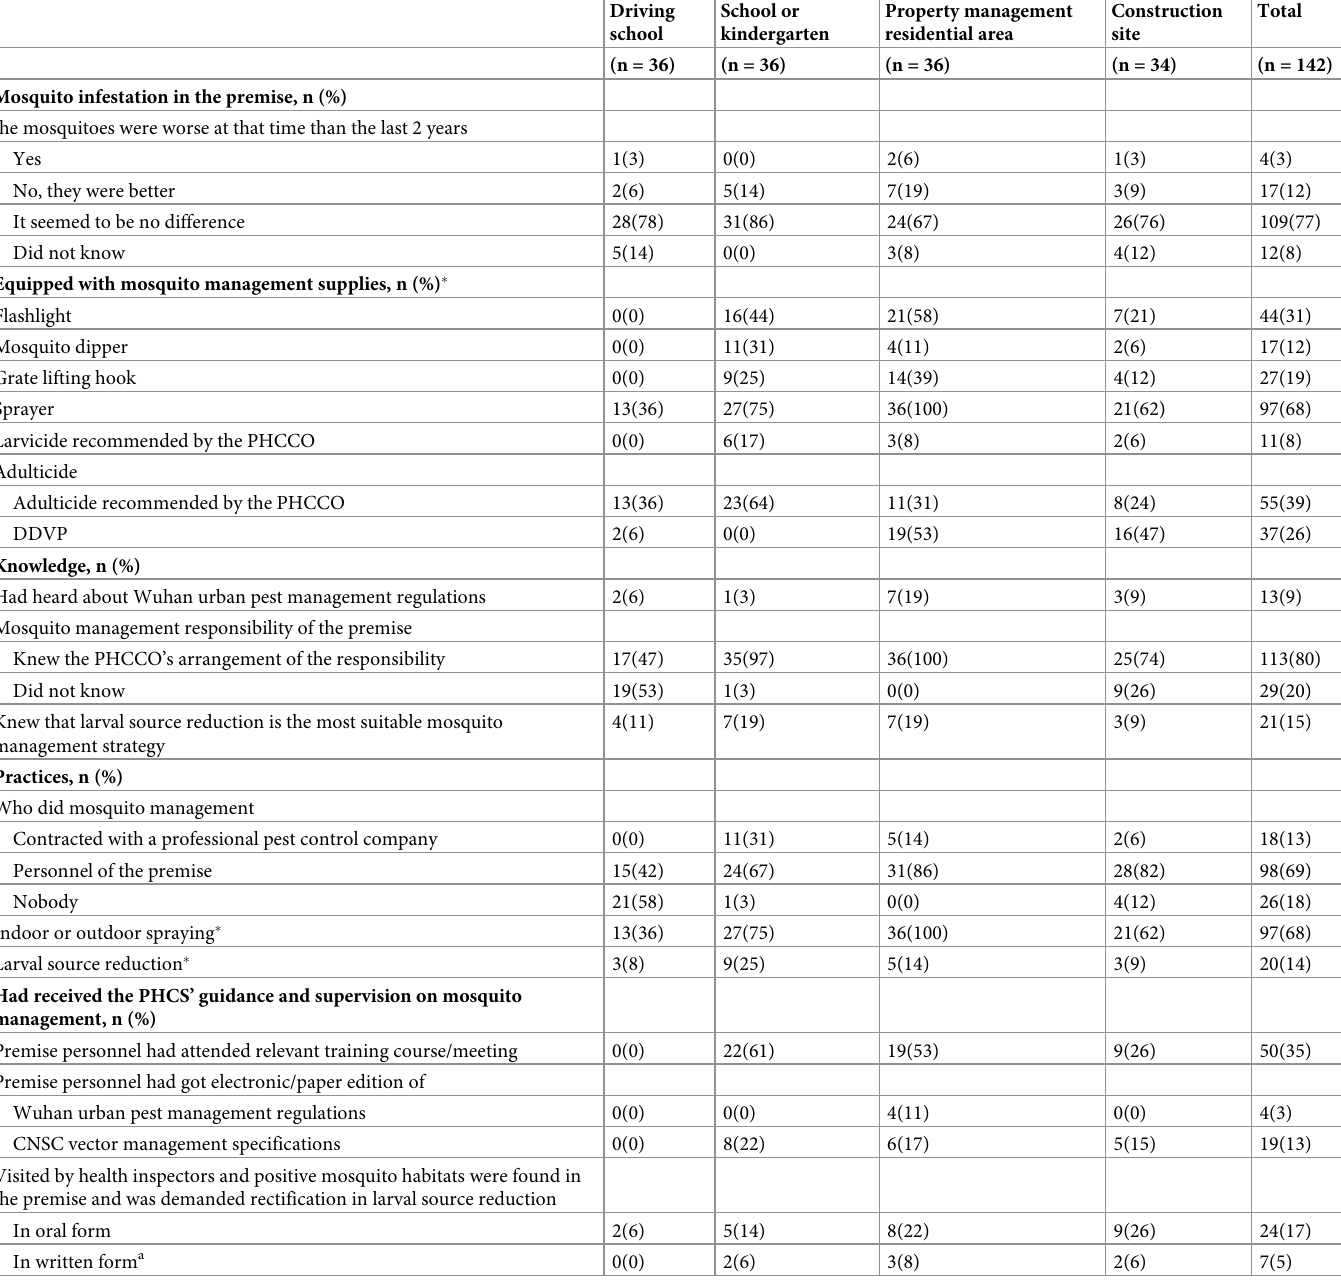
Table 2. Mosquito infestation and management supplies, knowledge, practices, the PHCS’ guidance and supervision surrounding NSC mosquito management of built-up areas of